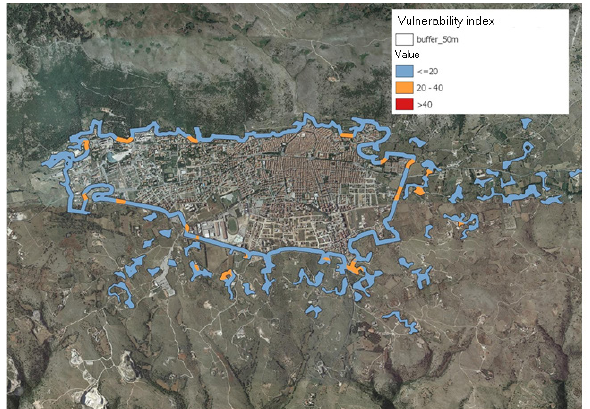
Figure 10 . Example of Vulnerability